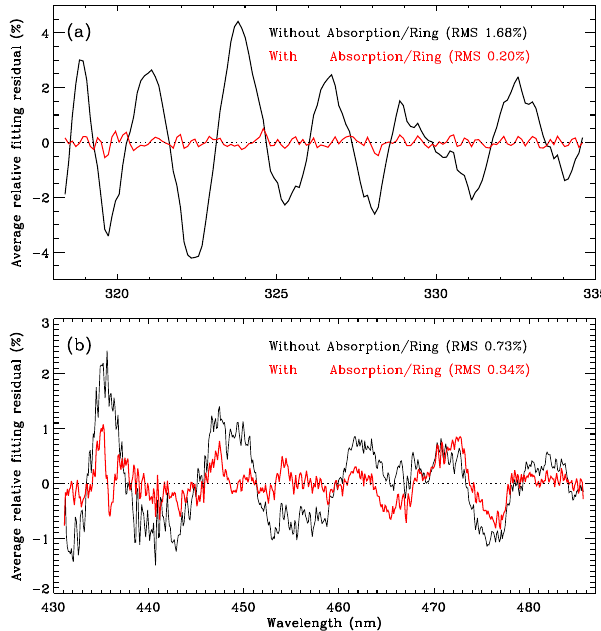
Figure 1. Comparison of average relative fitting residuals for ACAM data from 21 July 2011, with and without considering ab- sorption and ring effect for (a) the O 3 fitting window and (b) the NO 2 fitting window. The values in parentheses indicate the average root mean square (RMS) of the relative fitting